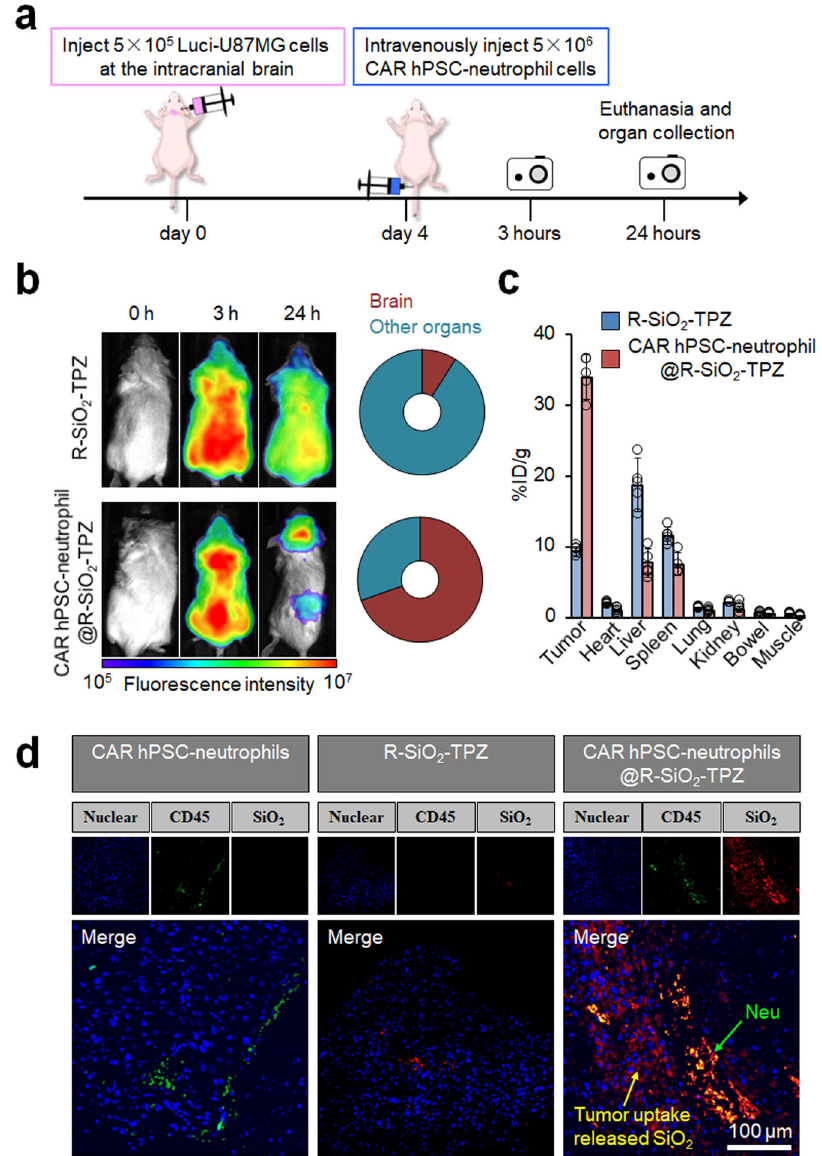
Fig. 6 | In vivo distribution of CAR neutrophil-delivered R-SiO 2 -TPZ nano- particles (NPs). a Schematic of intravenously administered Cy5-labeled CAR neu- trophil@R-SiO 2 NPs and R-SiO 2 NPsfor in vivo celltracking study. 5×10 5 luciferase (Luci)-expressing U87MG cells were stereotactically implanted into the right fore- brain of NRG mice. After 4 days, mice were intravenously treated with PBS, 5×10 6 Cy5-labeled CAR neutrophil@R-SiO 2 NPs and R-SiO 2 NPs. b Time-dependent bio- distribution of Cy5+ neutrophils in whole body, brain, and other organs was determined and quanti fi ed by fl uorescence imaging at the indicated